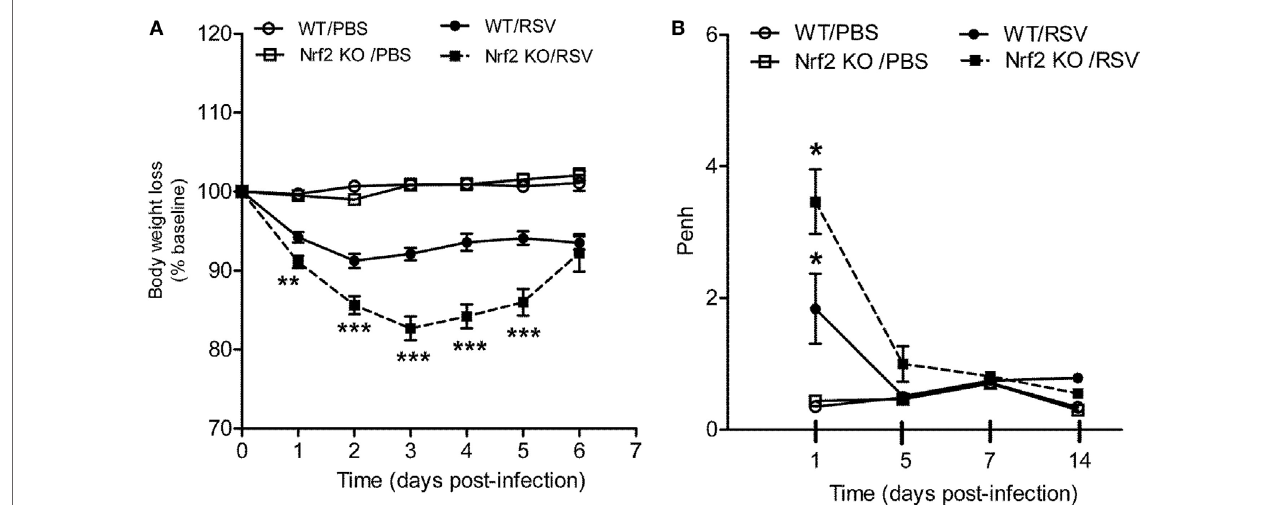
FigUre 1 | NF-E2-related factor 2 (Nrf2) gene deficiency in mice exacerbates clinical disease and airway obstruction following respiratory syncytial virus (RSV) infection. Under light anesthesia, groups of Nrf2 − / − (KO) and Nrf2 + / + [wild-type (WT) control] mice were infected intranasally (i.n.) with 10 7 plaque-forming units (PFU) of RSV or PBS. (a) Mice were monitored daily for changes in body weight and disease manifestation. Data are expressed as mean ± SEM ( n = 4–12 mice/group). ** p < 0.01, *** p < 0.001 when compared with WT/RSV at days 1, 2, 3, 4, and 5 post-infection. (B) Airway obstruction represented by baseline Penh was assessed by unrestrained plethysmography (Buxco Electronics, Inc., Sharon, CT). RSV-infected Nrf2 KO mice have increased airway obstruction compared to RSV-infected WT mice. Data are expressed as mean ± SEM ( n = 3–8 mice/group). * p < 0.05 WT/RSV compared with WT/PBS, Nrf2 KO/RSV compared with Nrf2 KO/PBS, and Nrf2 KO/RSV compared with WT/RSV at day 1